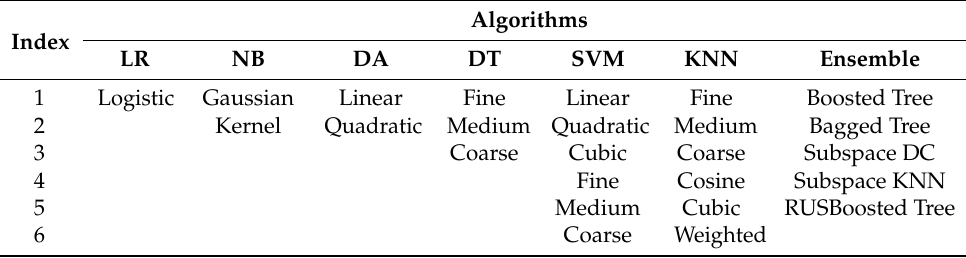
Table 1. The algorithms used for tests.